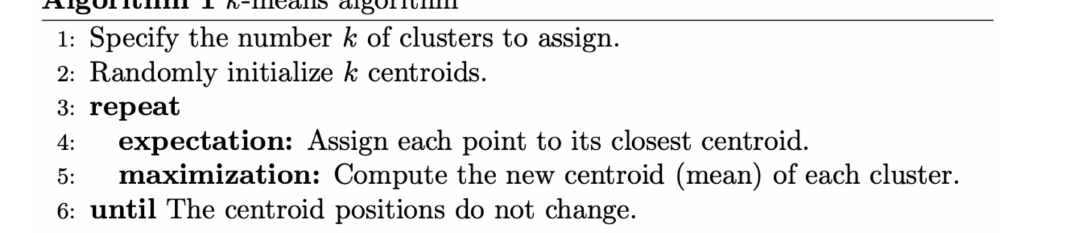
Figure 3. Pseudo code for the K-means clustering algorithm. The initialization of the centroids is chosen from the already existing collection of data. The standard k-means algorithm utilizes Euclidean distance for assigning points their closest centroid, but this type of distance calculation does not work with regards to binary data (1 s and 0